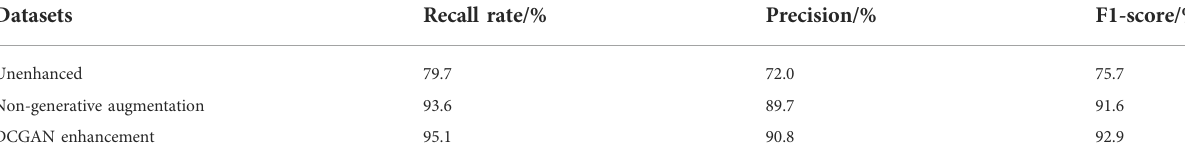
TABLE 4 Recognition effects of models trained on different datasets.